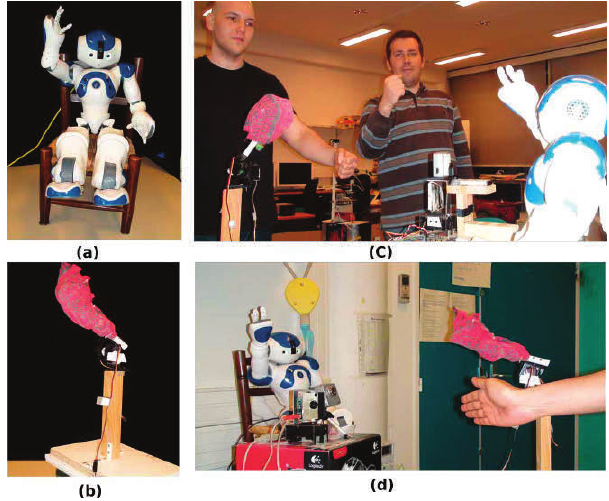
Figure 1. Experimental setup. (a) Nao (b) a basic automaton (1 degree of free- dom) (c) & (d) Overall setup for human-robot interaction.